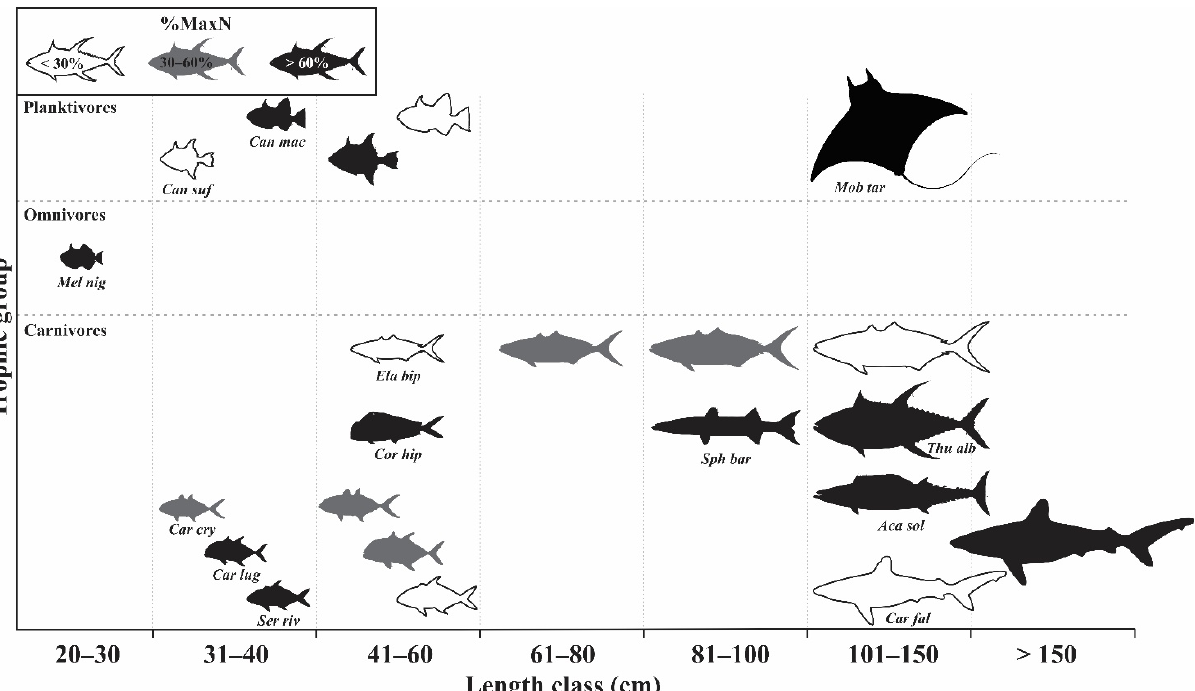
Figure 2. Percentage of total relative abundance (%TMaxN) by length class and trophic group of the fish species recorded in the pelagic environment of SPSPA. Aca sol: Acanthocybium solandri ; Can mac: Canthidermis maculata ; Can suf: Canthidermis sufflamen ; Car cry: Caranx crysos ; Car lug: Caranx lugubris ; Car fal: Carcharhinus falciformis ; Cor hip: Coryphaena hippurus ; Ela bip: Elagatis bipinnulata ; Mel nig: Melichthys niger ; Sph bar: Sphyraena barracuda ; Mob tar: Mobula tarapacana ; Ser riv: Seriola rivoliana ; Thu alb: Thunnus albacares